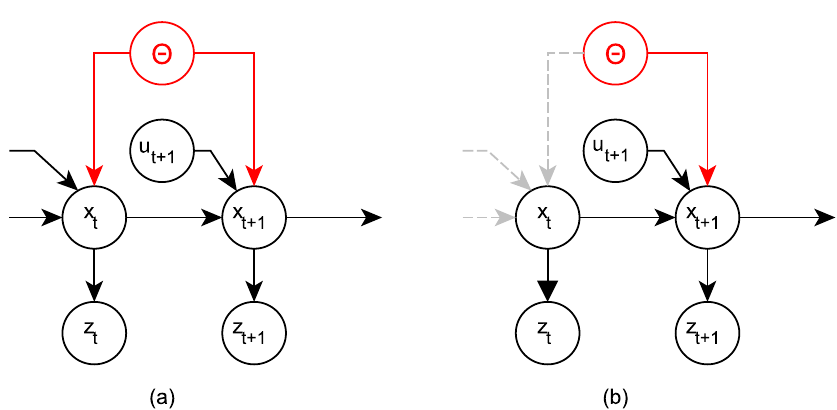
Figure 3. Graphical model including the vehicle parameters ( a ). Since we perform simulation from a known pose using the movement model, the connections to x t disappear ( b ).